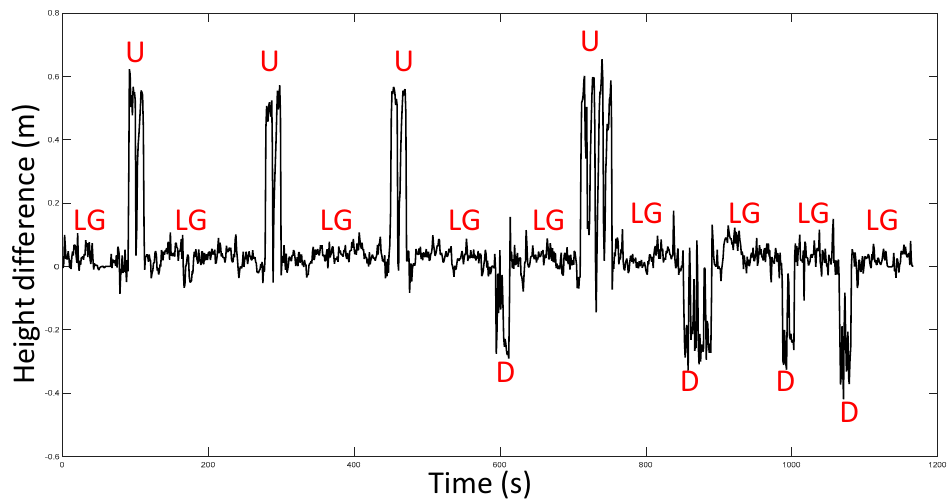
Figure 20. Height difference and the level ground/upstairs/downstairs estimation results. LG is short for level ground. U is short for upstairs. D is short for downstairs.